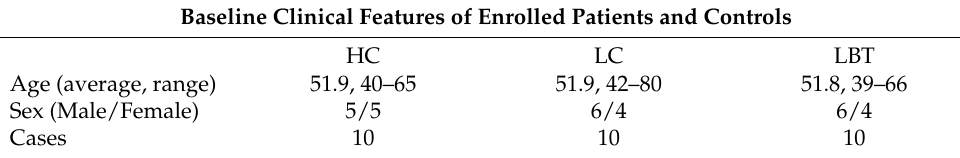
Table 1. Baseline clinical pathological features of enrolled subjects. Baseline Clinical Features of Enrolled Patients and